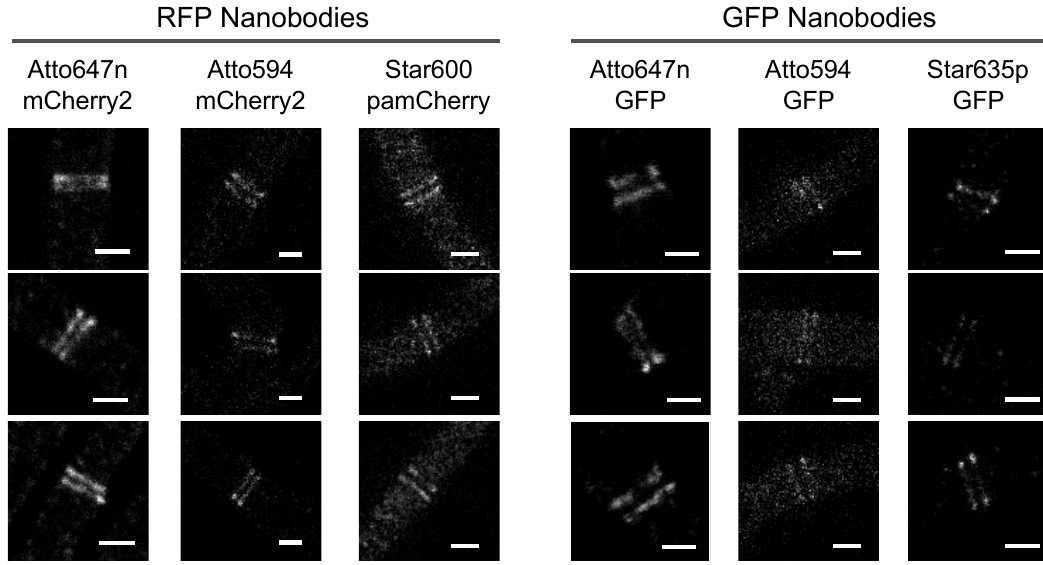
Figure 4. STED images of DivIVA dual bands visualized with nanobodies. B. subtilis cells expressing GFP, mCherry2 or PAmCherry fused to DivIVA were imaged using nanobodies containing the indicated organic fluorescent dyes. Scale bars 500 nm.